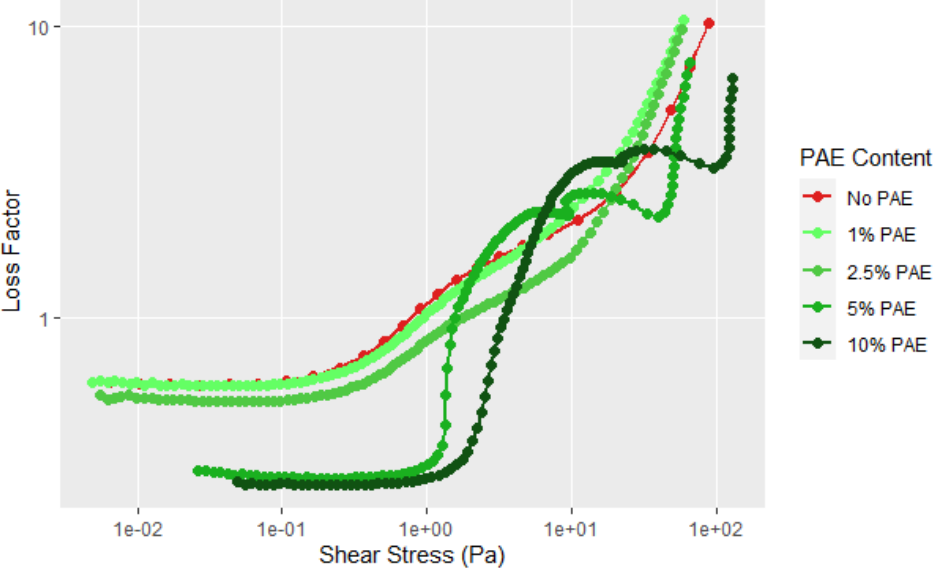
Figure 13. Loss factor curves for the data given in Figure 11.